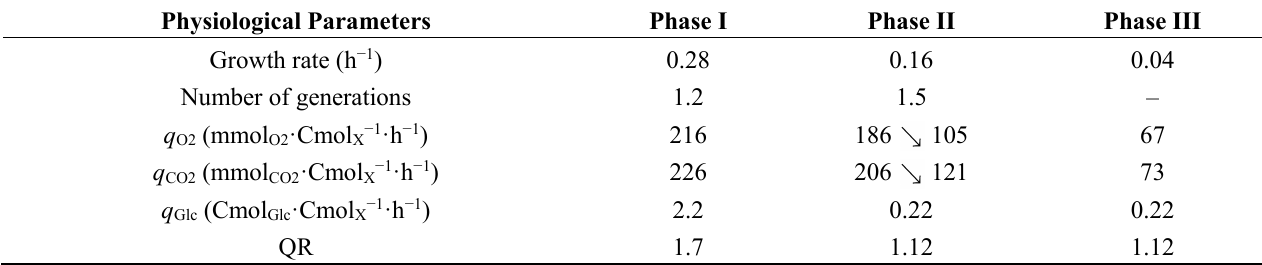
Table 9. Kinetic growth parameters of Deinococcus geothermalis DSM-11302 under controlled nutritional and culture